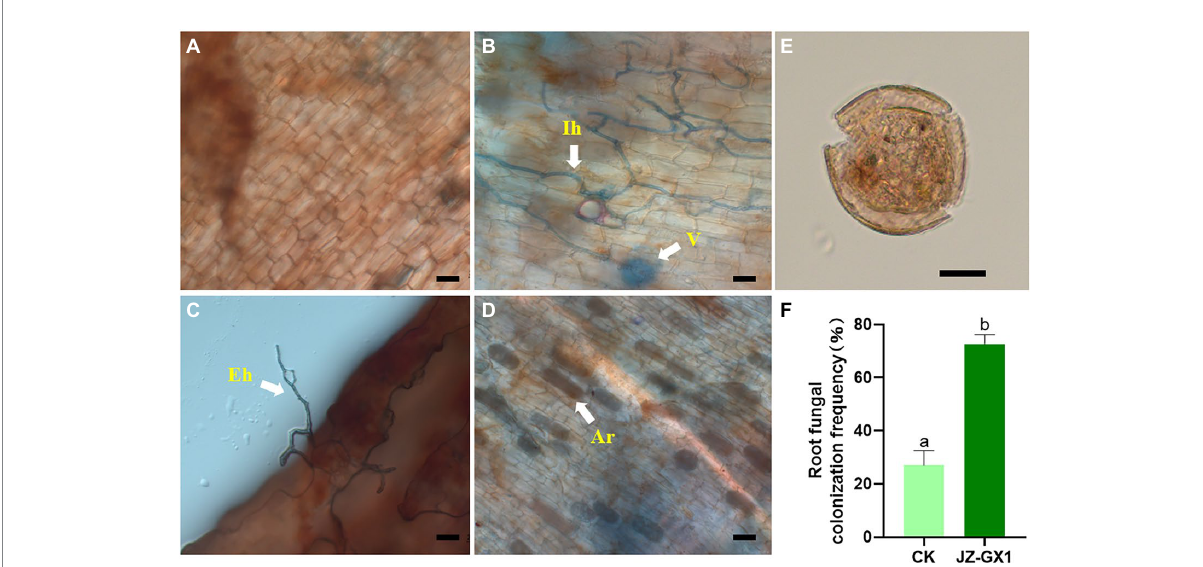
FIGURE 8 Typical structure of arbuscular mycorrhizal fungi (AMF) in the root system of Cinnamomum camphora . Uninfected (A) and infected (B–D) plant roots, spore morphotypes detected in the rhizosphere (E) and changes in root fungal colonization frequency (F) . Ar, arbuscule; V, vesicle; Eh,